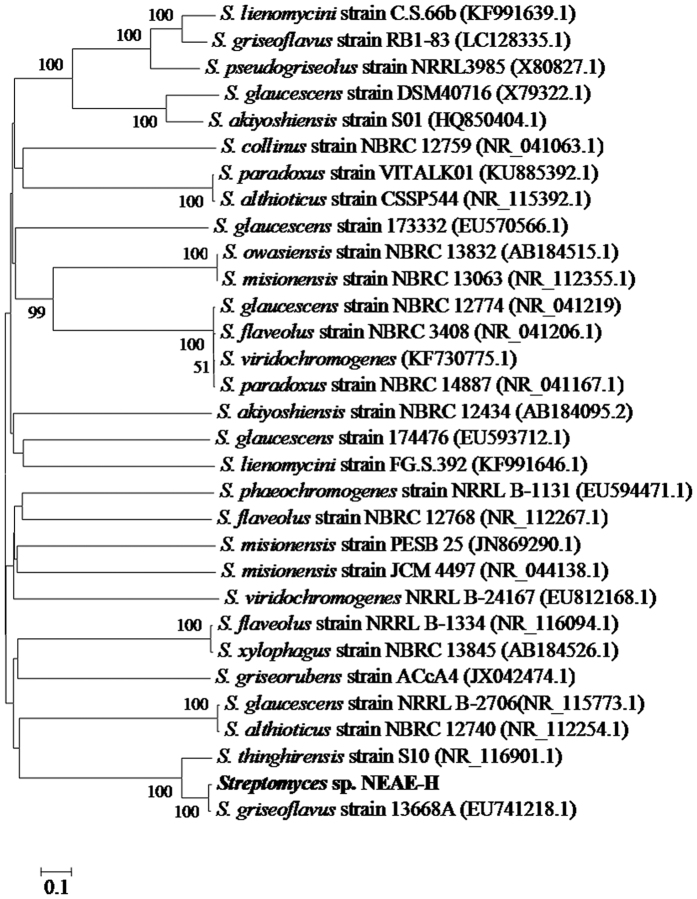
Neighbour-joining phylogenetic tree based on 16 S rRNA gene sequences, showing the relationships between strain NEAE-H and related species of the genus Streptomyces.Only bootstrap values above 50%, expressed as percentages of 500 replications, are shown at the branch points. GenBank sequence accession numbers are indicated in parentheses after the strain names. Phylogenetic analyses were conducted in the software package MEGA4. Bar, 0.1 substitution per nucleotide position.